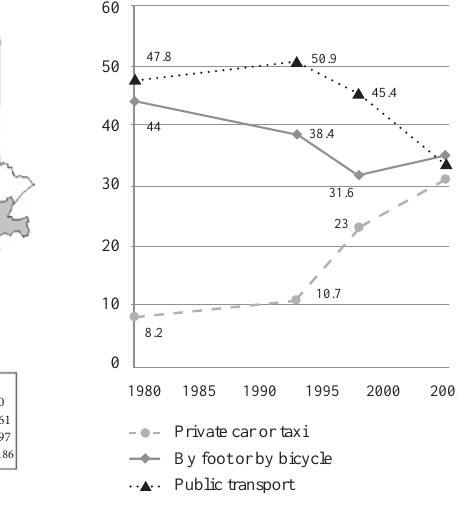
fig. 2. Trips modal split tendencies in Vilnius city